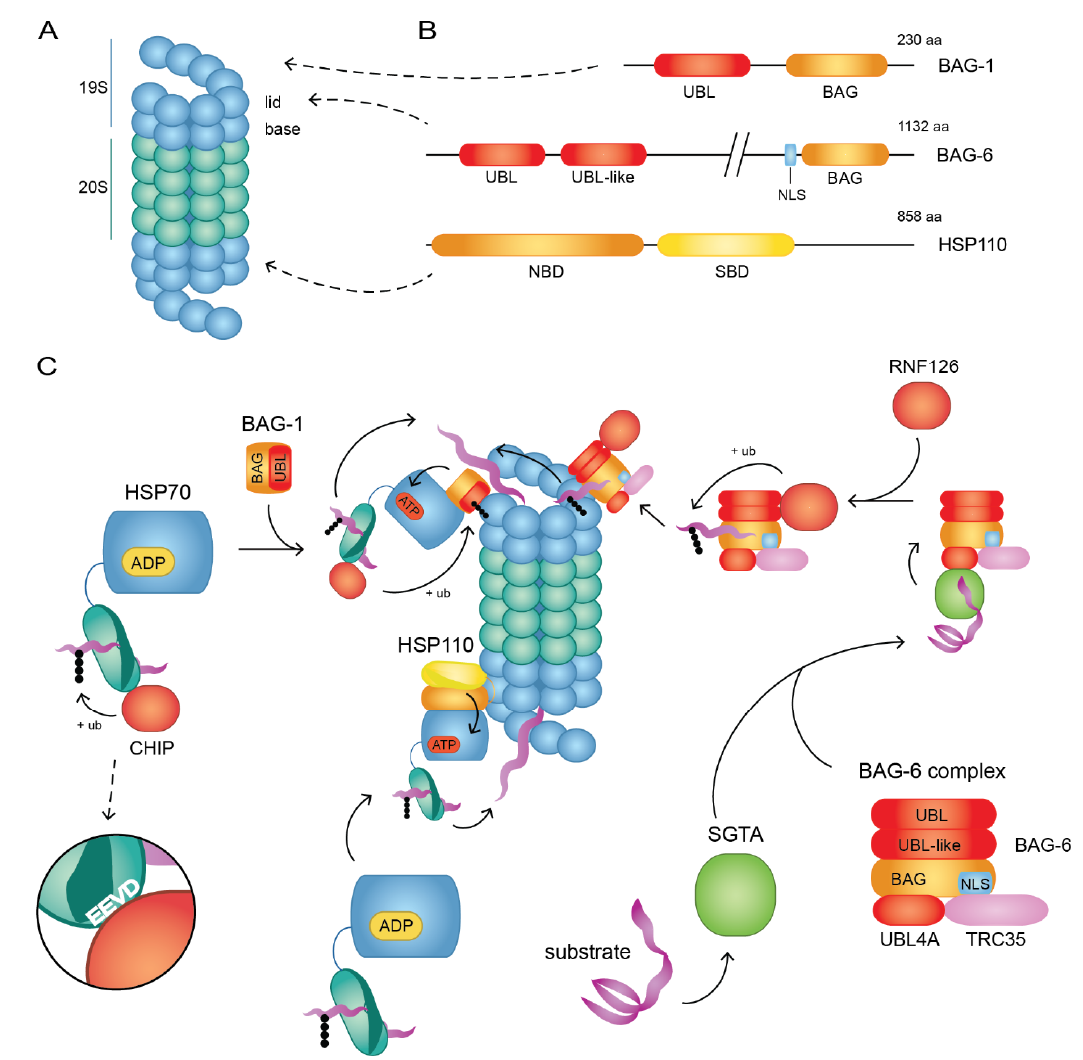
Figure 2. Delivery pathways of misfolded proteins to the 26S proteasome. ( a ) The 26S proteasome with one catalytic 20S particle (green) and two regulatory 19S particles (blue) each containing a lid and a base subcomplex. ( b ) Schematic overviews of BAG-1, BAG-6 and HSP110 domain structures, which bind the regulatory 19S particles (arrows). UBL: ubiquitin-like, BAG: Bcl2-associated athanogene, NLS: nuclear localization signal, NBD: nucleotide-binding domain, SBD, substrate-binding domain, aa: amino acids. ( c ) Delivery pathways to the 26S proteasome. Left: CHIP binds HSP70 through